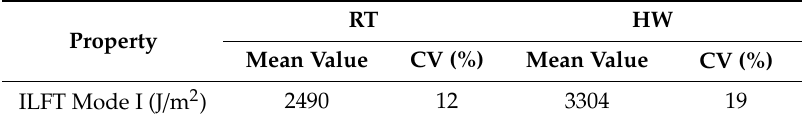
Table 10. Effect of hot-wet storage aging on interlaminar fracture toughness in Mode